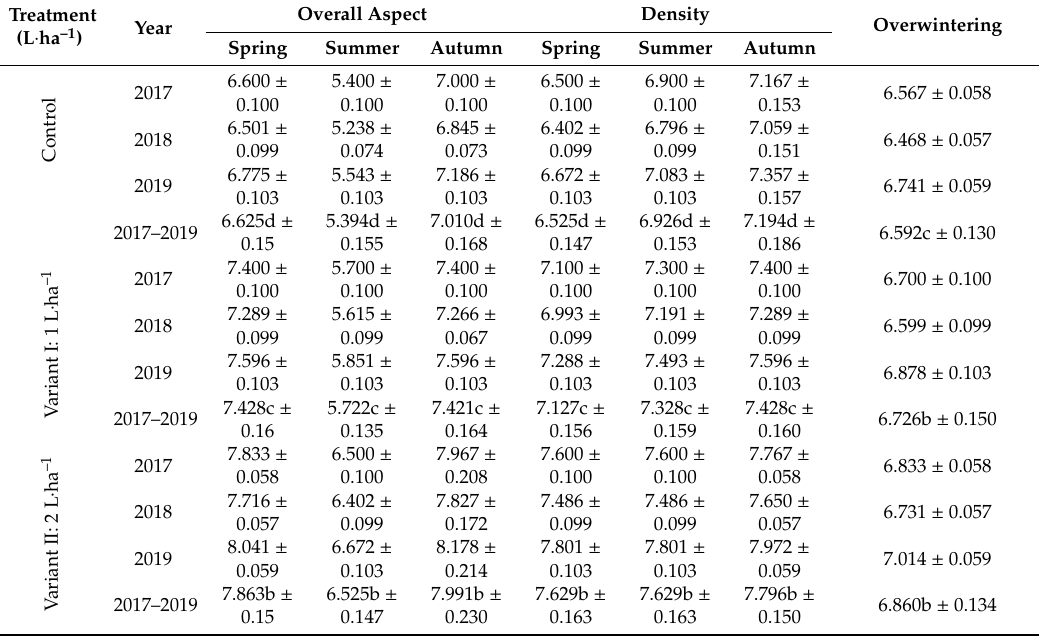
Table 3. Assessment of overall lawn characteristics on a 9-point scale (mean values ± standard deviation). Treatment (L · ha –1